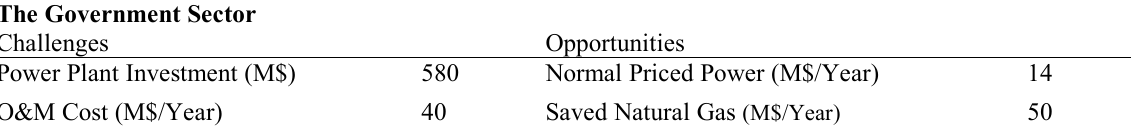
Table 17 . Economic opportunities and challenges of the government as power plant investor and operator (2 nd Scenario)